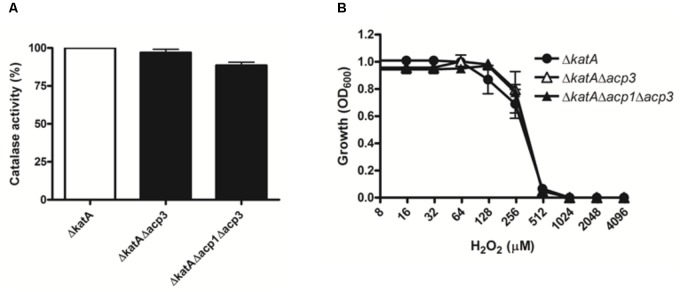
The H2O2 resistance of acp3 mutant is mediated by KatA. In contrast to the effect of acp3 deletion on catalase activity and susceptibility to H2O2 in the wild-type background, ΔkatA, ΔkatAΔacp3, and ΔkatAΔacp1Δacp3 mutant strains exhibited similar (A) Catalase activity and (B) resistance against H2O2, suggesting that the increased catalase activity and resistance to H2O2 in the Δacp3 strain is dependent on KatA. Data are presented as mean ± SEs from three independent experiments.